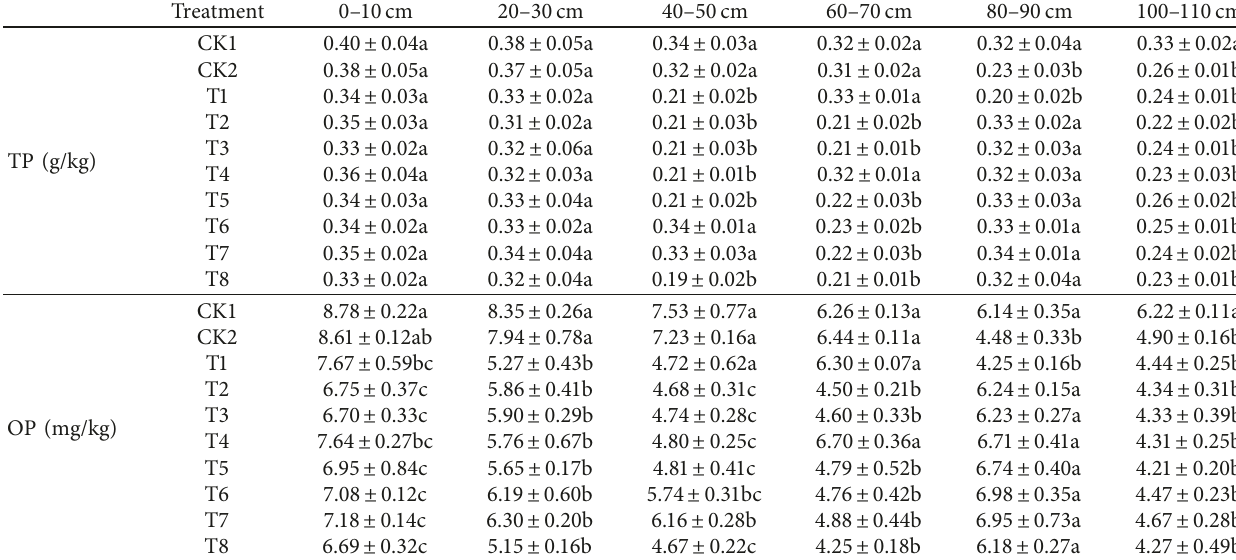
Table 5: Total and available phosphorus of interlayered soil profiles.